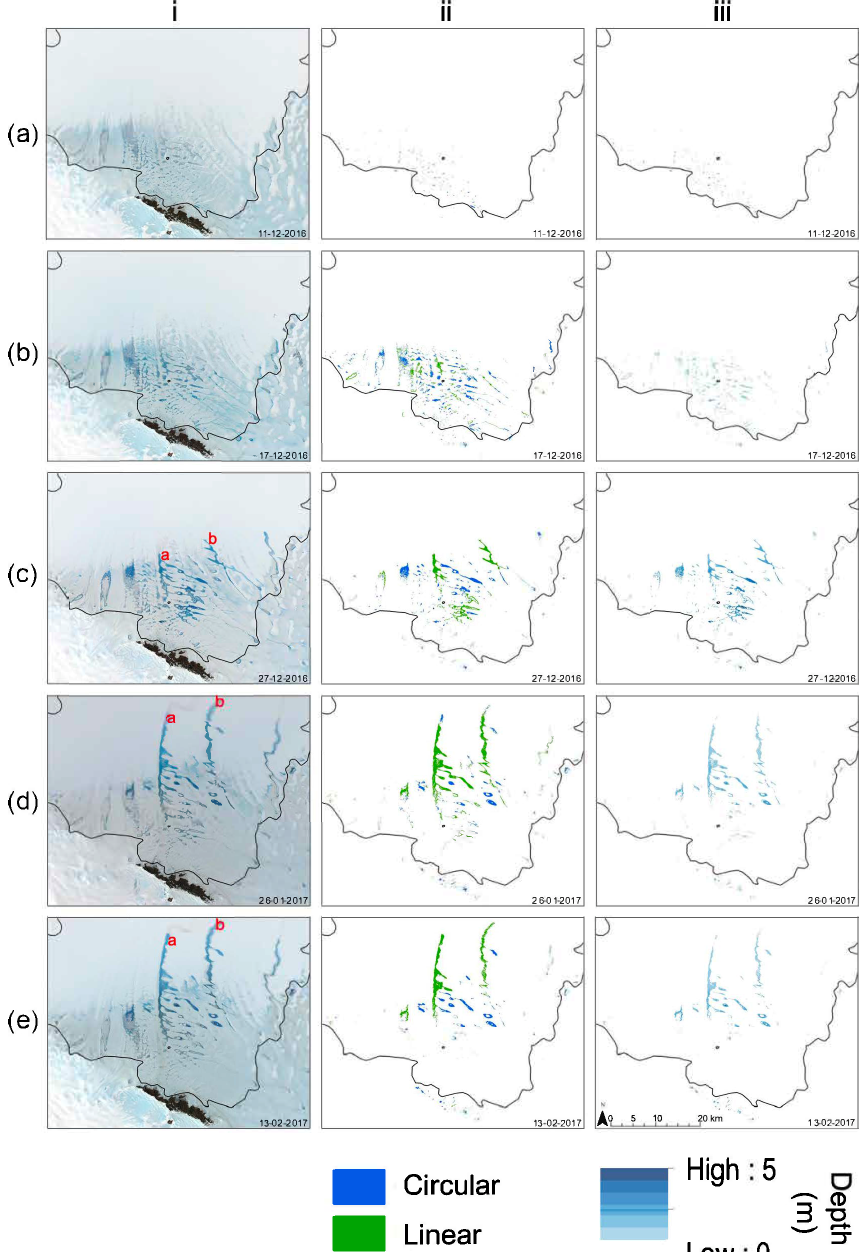
Figure 5. Five of the 11 dates studied in the 2016–2017 melt season (represented by labels a – e ), and their corresponding (i) RGB images, (ii) area masks for circular and linear features, and (iii) depth masks. Date stamps are in the bottom right-hand corner of each image. See Fig. S2 (https://doi.org/10.5446/47526, Dell et al., 2020a) for all RGB images, Fig. S3 (https://doi.org/10.5446/47524, Dell et al., 2020b) for all lake and stream area masks, and Fig. S4 (https://doi.org/10.5446/47525, Dell et al., 2020c) for all depth masks produced in this